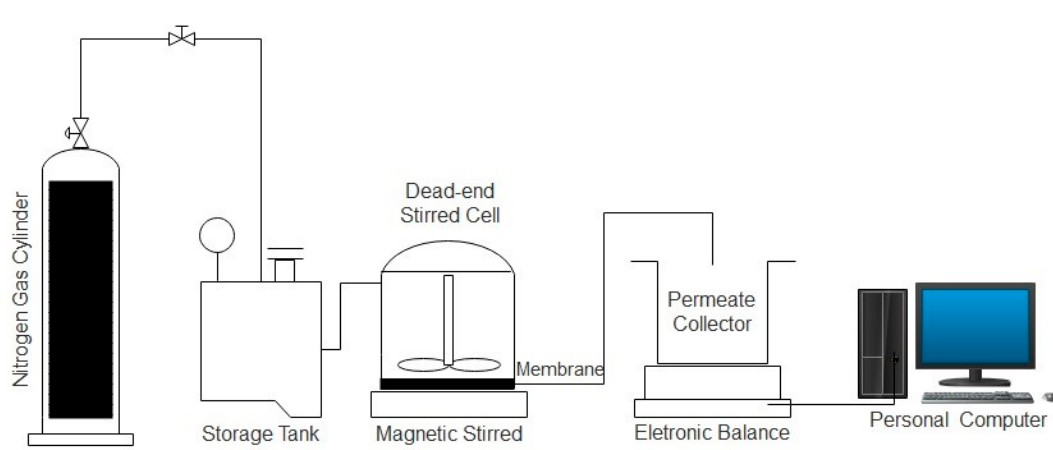
Figure 2. Process configuration for batch dead-end membrane filtration with stirred cell.